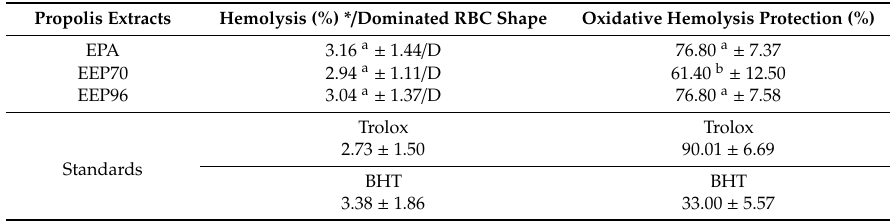
Table 4. Hemolytic activity of propolis extracts (at 0.1 mg / mL after 1 h at 37 ◦ C) and their cytoprotective e ff ects (at 0.05 mg / mL) against 2,2 (cid:48) -azobis-(2-methylpropionamidine) dihydrochloride (AAPH)-induced oxidative